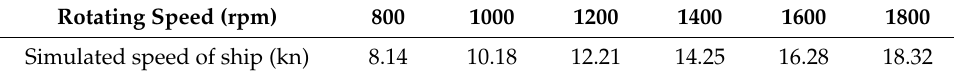
Table 2. The corresponding simulated speed of the disc at di ff erent speeds.